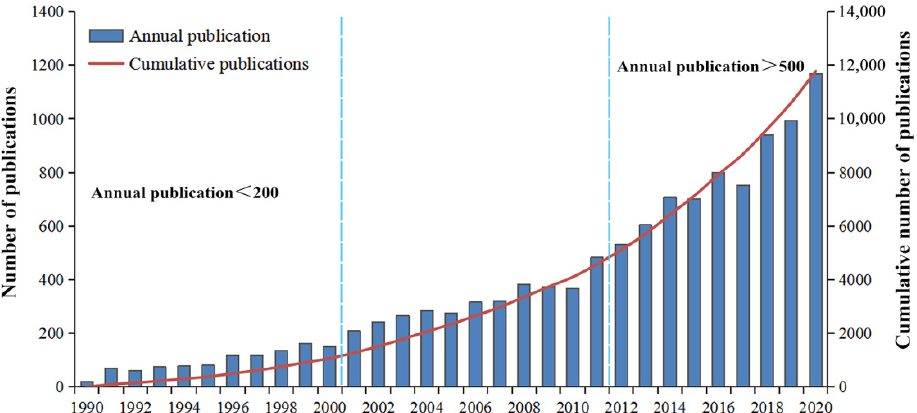
Figure 1. Time evolution of annual publication and cumulative number from 1990 to 2020.